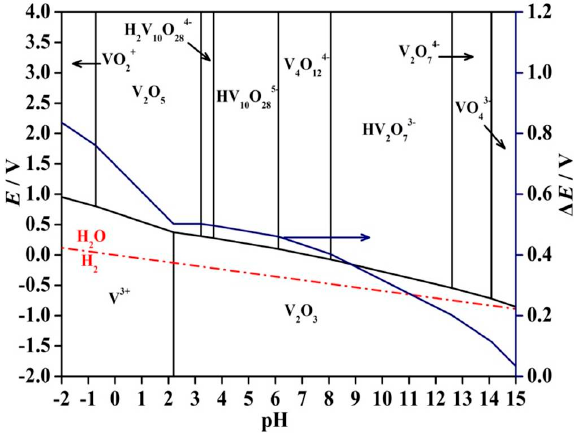
Figure 1. Potential–pH diagram for V–H 2 O system (only includes V (V) and V (III) species) at 298 K with activities of dissolved vanadium of 1 mol/L and H 2 partial pressure of 1 atm.